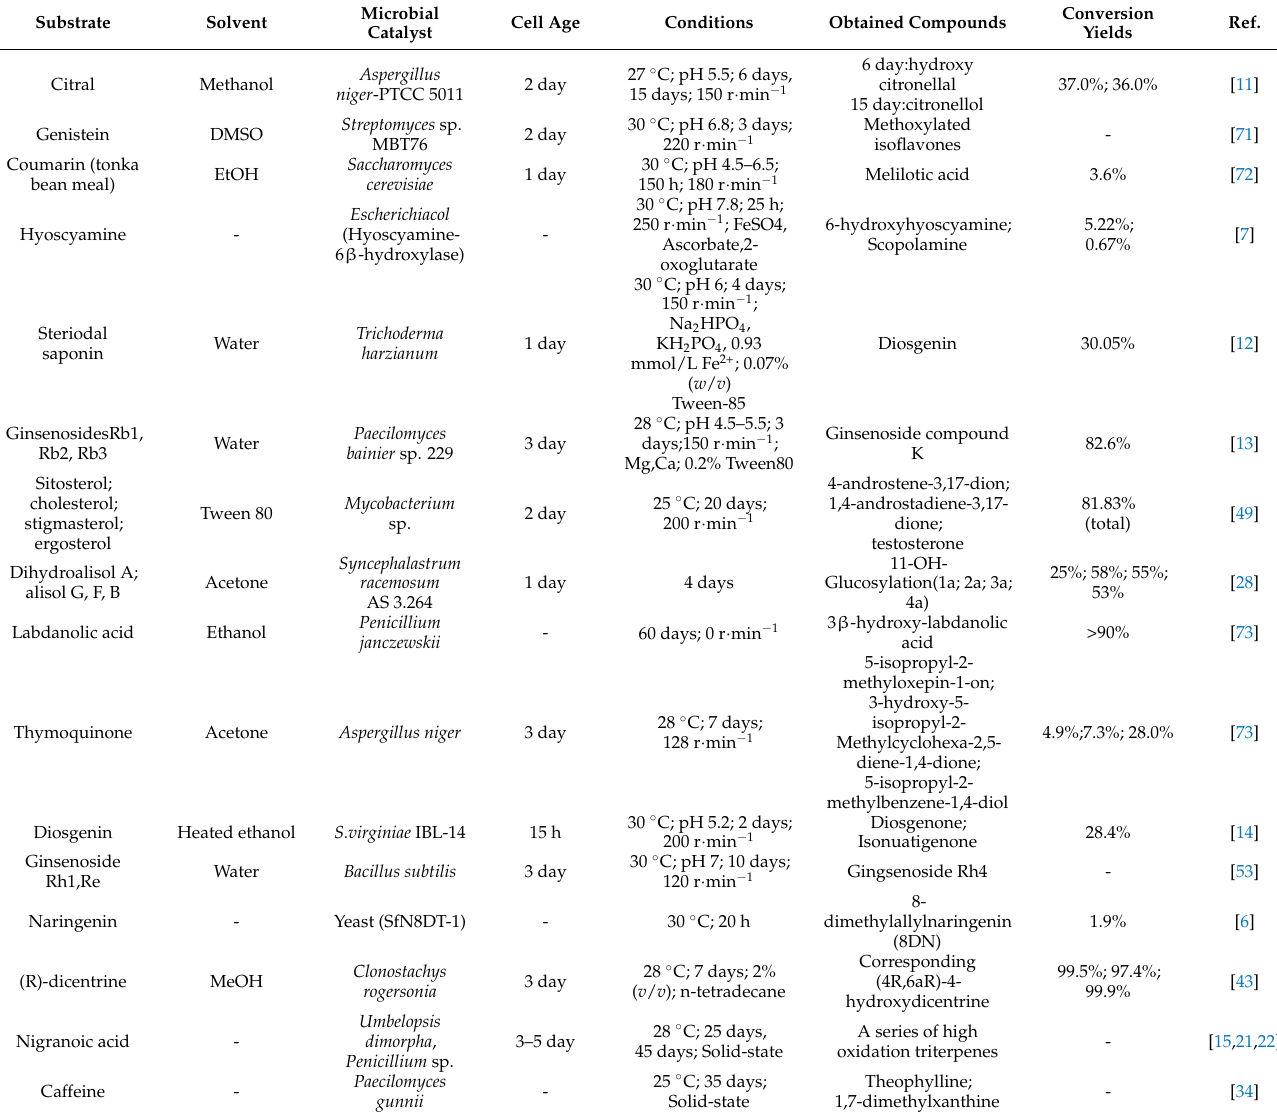
Table 1. Examples of fermentation conditions for microbial